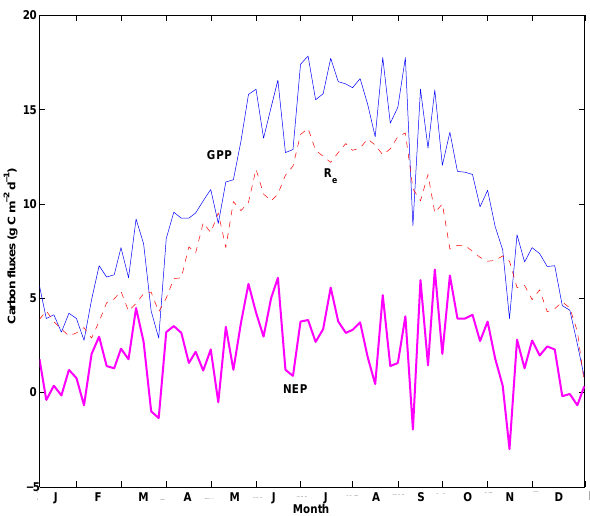
Fig. 3. Five-day ensemble means of CO 2 component fluxes for the year of 2004 measured at the Qian Yinzhou flux tower in an ever- green needleleaf forest, China. Measured net ecosystem productiv- ity (NEP) was partitioned into gross primary productivity (GPP) and ecosystem respiration ( R e ) using procedures described in Sect. 2.2.